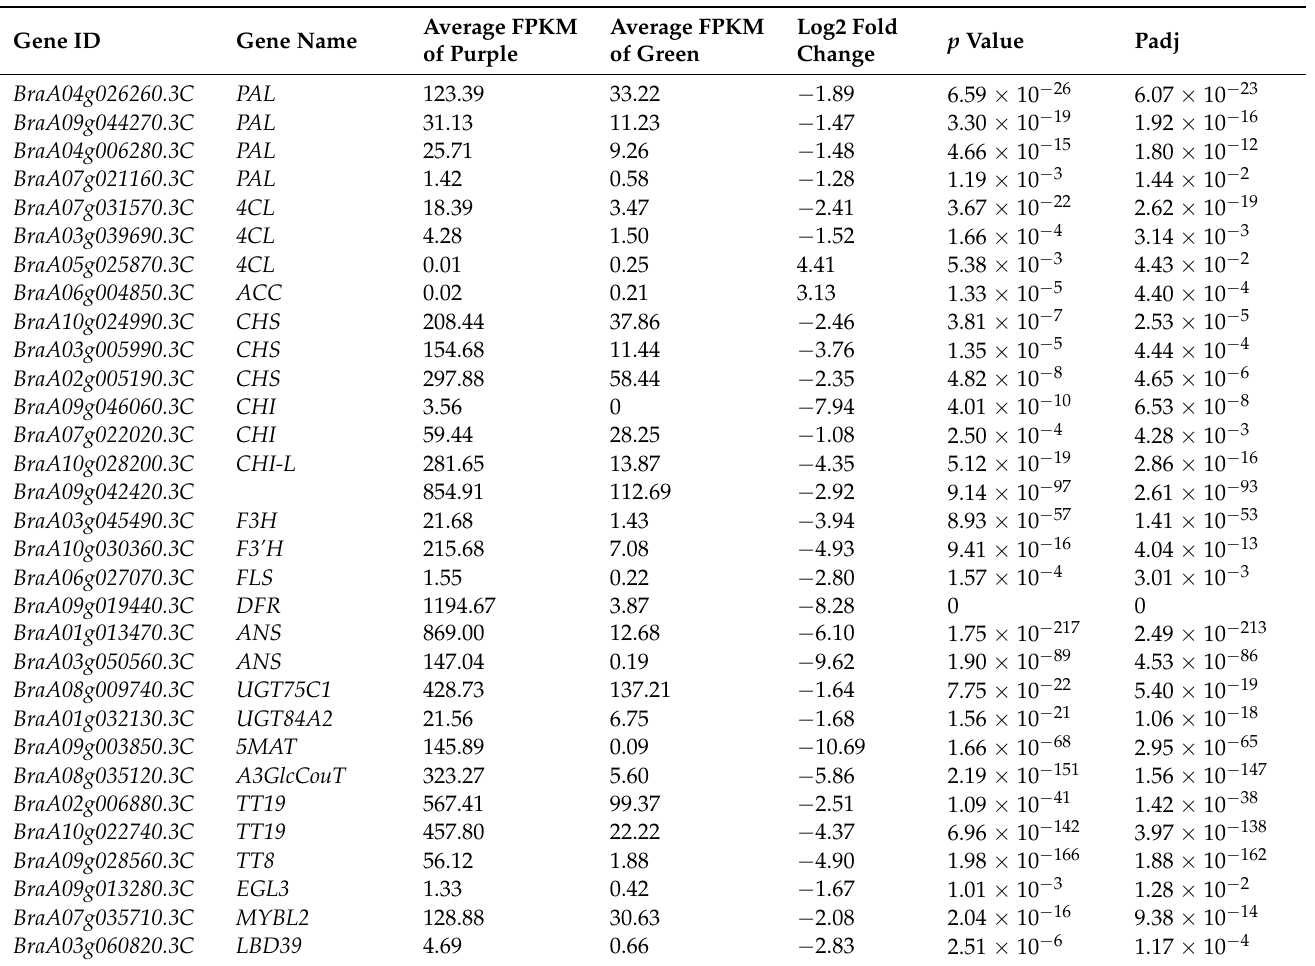
Table 2. DEGs related to anthocyanin biosynthesis and regulation between purple non-heading Chinese Cabbage and its green